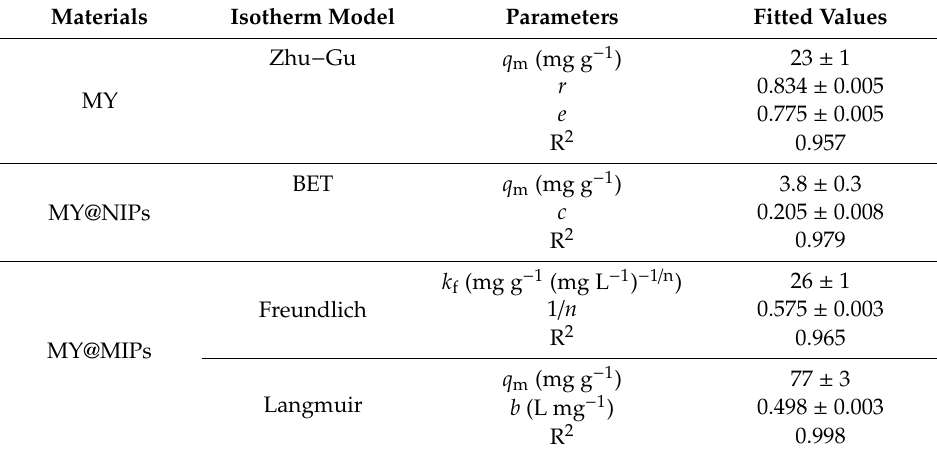
Table 3. Equilibrium parameters corresponding to the adsorption of SMX onto MY, MY@NIPs, and MY@MIPs from ultrapure water.